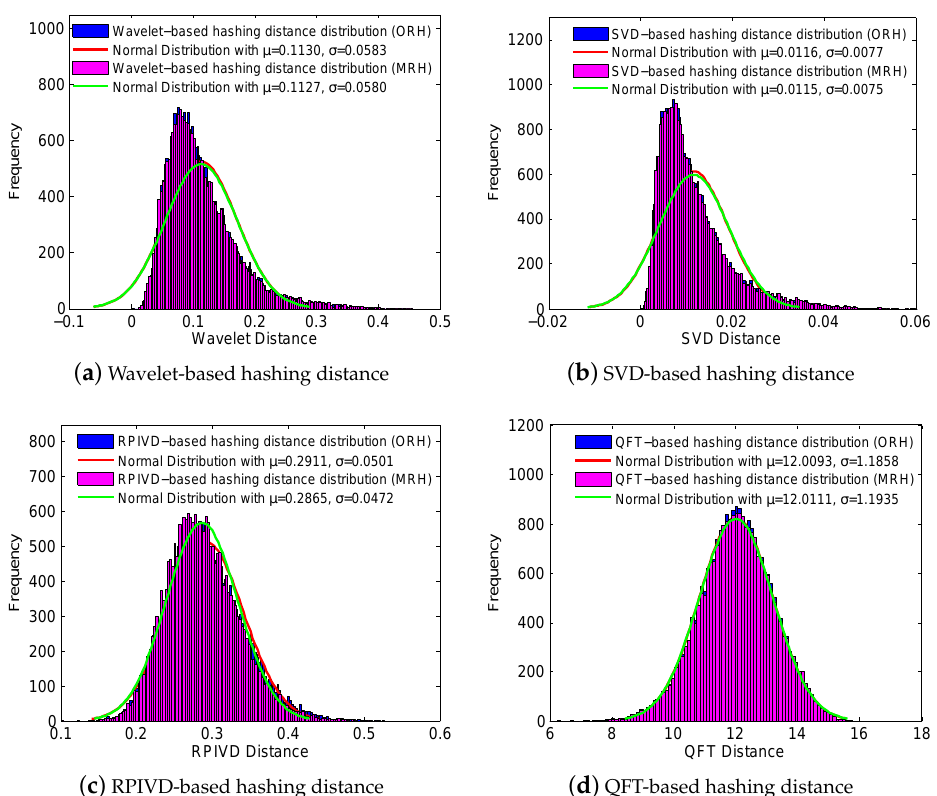
Figure 4. Distribution of hashing distances between hashing pairs with varying